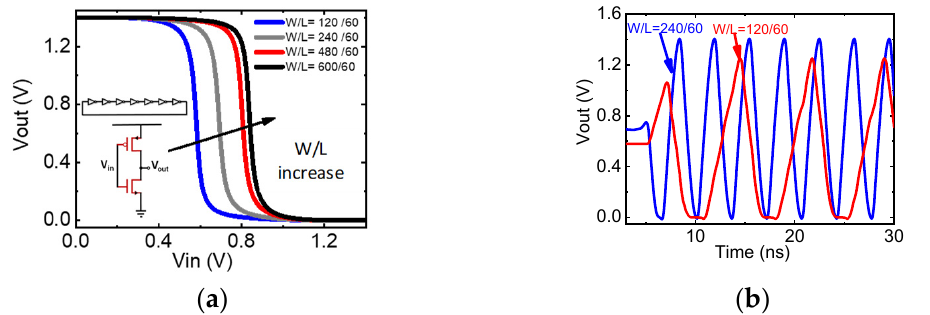
Figure 7. ( a ) The circuit diagram of a ring oscillator composed of seven-stage inverters connected in series; the inverter structure is shown at the bottom. The relation between V-out and V-in for the inverter: with the size of the p-type MOSFET pull up transistor increasing, the pull up driver capability increases as well, causing the curves to shift to the right. ( b ) Transient simulation results of the ring oscillator: with the size of the p-type MOSFET transistor decreasing, the frequency of the oscillator is reduced and saturation appears at the lowest point of oscillation.